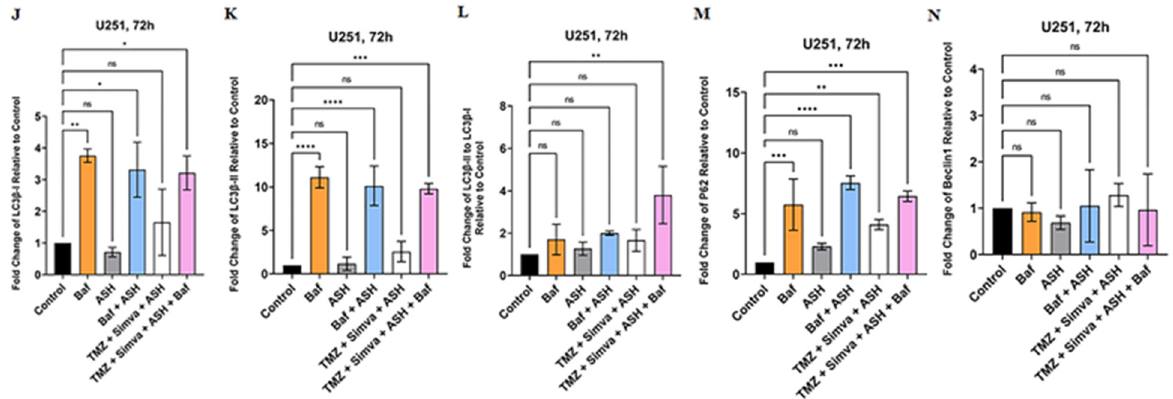
Figure 4. Simvastatin, Temozolomide, and Acetylshikonin combination treatments change autophagy flux in human glioblastoma cells. U87 and U251 cells were treated with TMZ 100 μ M, Simva (2.5, 1 μ M respectively), ASH 1.5 μ M, TMZ/Simva and TMZ/Simva/ASH for 48 h. The formation of acidic vesicular organelles was assessed using acridine orange (AO). The green fluorescence turned to red AVOs in the treatment conditions (white arrows ( A , B )). The percentage of AVO positive cells were evaluated. All treatments significantly increased the percentage of AVO positive cells in both cell lines compared to the time match vehicle control. The cells treated with TMZ/Simva/ASH showed the highest percentage of AVO positive cells (* = p < 0.05, *** = p < 0.001) ( C ). We further evaluated autophagy in different experimental conditions using immunoblotting. GBM cells were treated with Bafilomycin A1 (autophagy flux inhibitor) (5 nM), ASH, Baf/ASH, TMZ/Simva/ASH and Baf/TMZ/Simva/ASH for 72 h (all concentrations were the same as AO experiments). p62 degradation, LC3 β lipidation and formation of LC3 β -II and Beclin-1 expressions were evaluated using immune blotting. Ponceau S was utilized as loading control ( D ). ASH increased the turnover of autophagosomes in both U87 and U251 cells, although it was not statistically significant ( E – H , J – N ). Baf significantly increased LC3 β -II lipidation and decreased p62 degradation in both U87 and U251 cells, confirming the effect of ASH in autophagy and autophagosome turnover ( E – I ; J – M ). TMZ/Simva/ASH partially inhibited autophagy flux, which is confirmed by the non-significant increase of LC3 β -II and non-significant decrease in p62 degradation. Baf significantly induced LC3 β lipidation, and accumulation of p62 in combination with TMZ/Simva/ASH treatment in both U87 and U251 cells ( E – H , J – M ). Beclin-1 is not involved in ASH, and